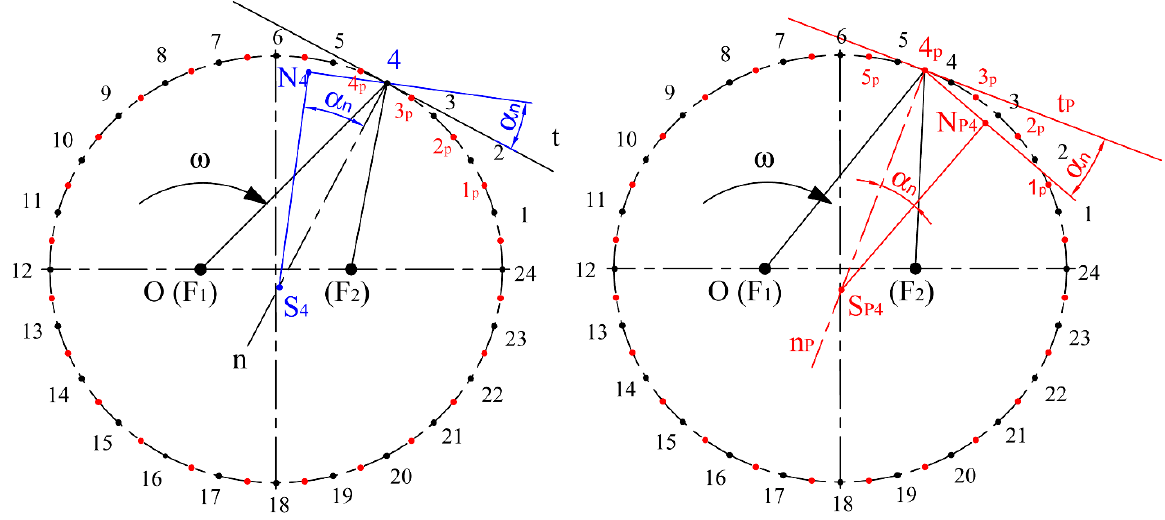
Figure 10. Construction of the last points of mesh N i .